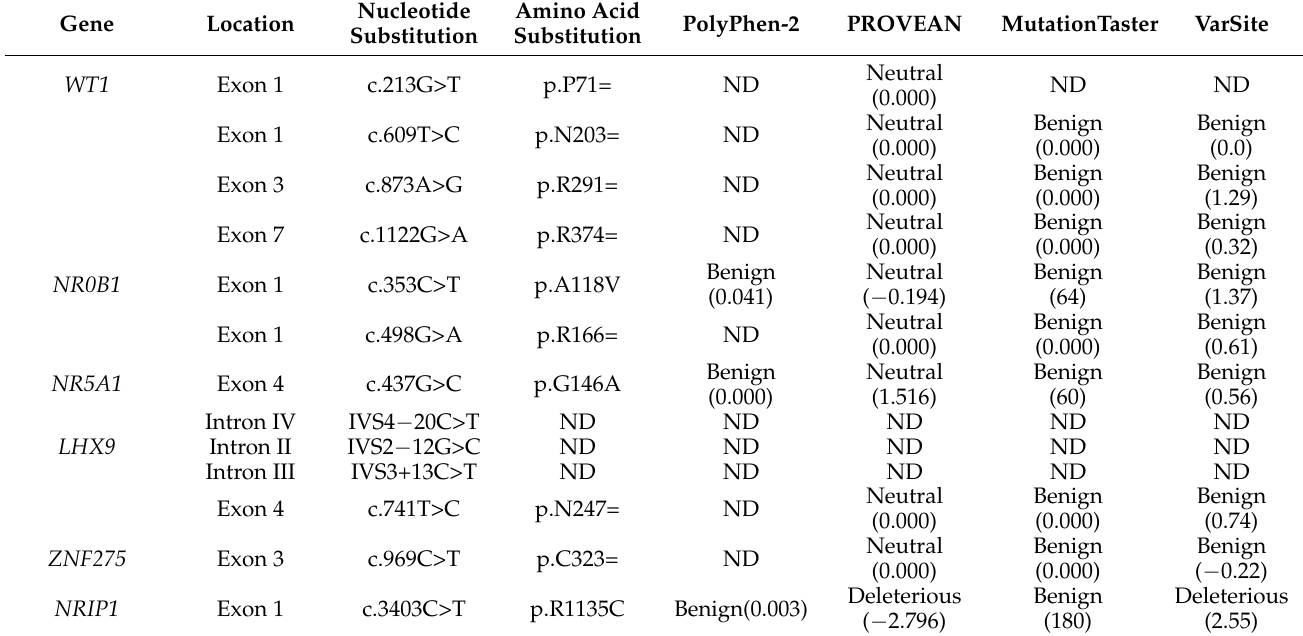
Table 2. A summary of the predicted functional effects of the WT1 (NM_024426.6),